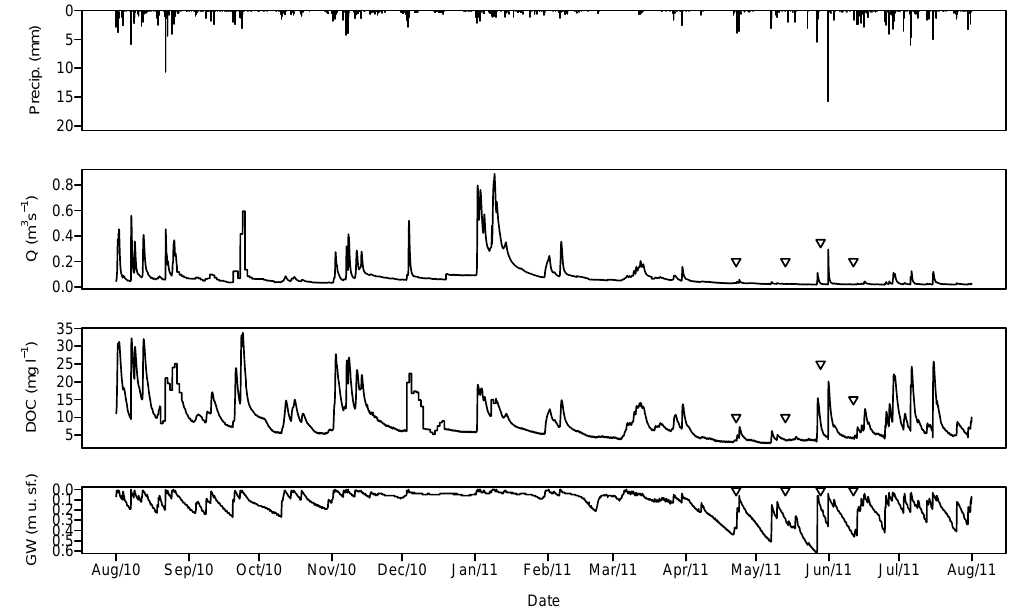
Fig. 1. Precipitation, discharge ( Q ), DOC concentration and riparian groundwater level (m u. sf.=meter under surface) in the Lehstenbach catchment. The O indicate groundwater sampling dates for DOC quality